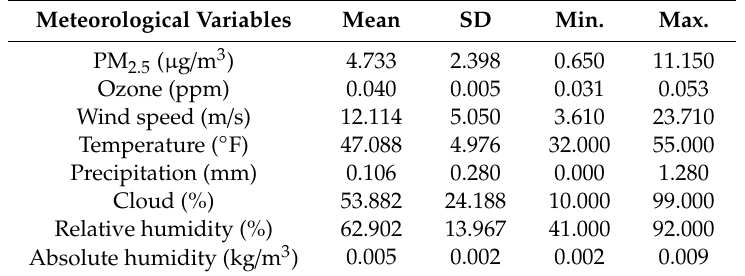
Table 1. Descriptive statistics of PM 2.5 , ozone, and meteorological variables across all days.